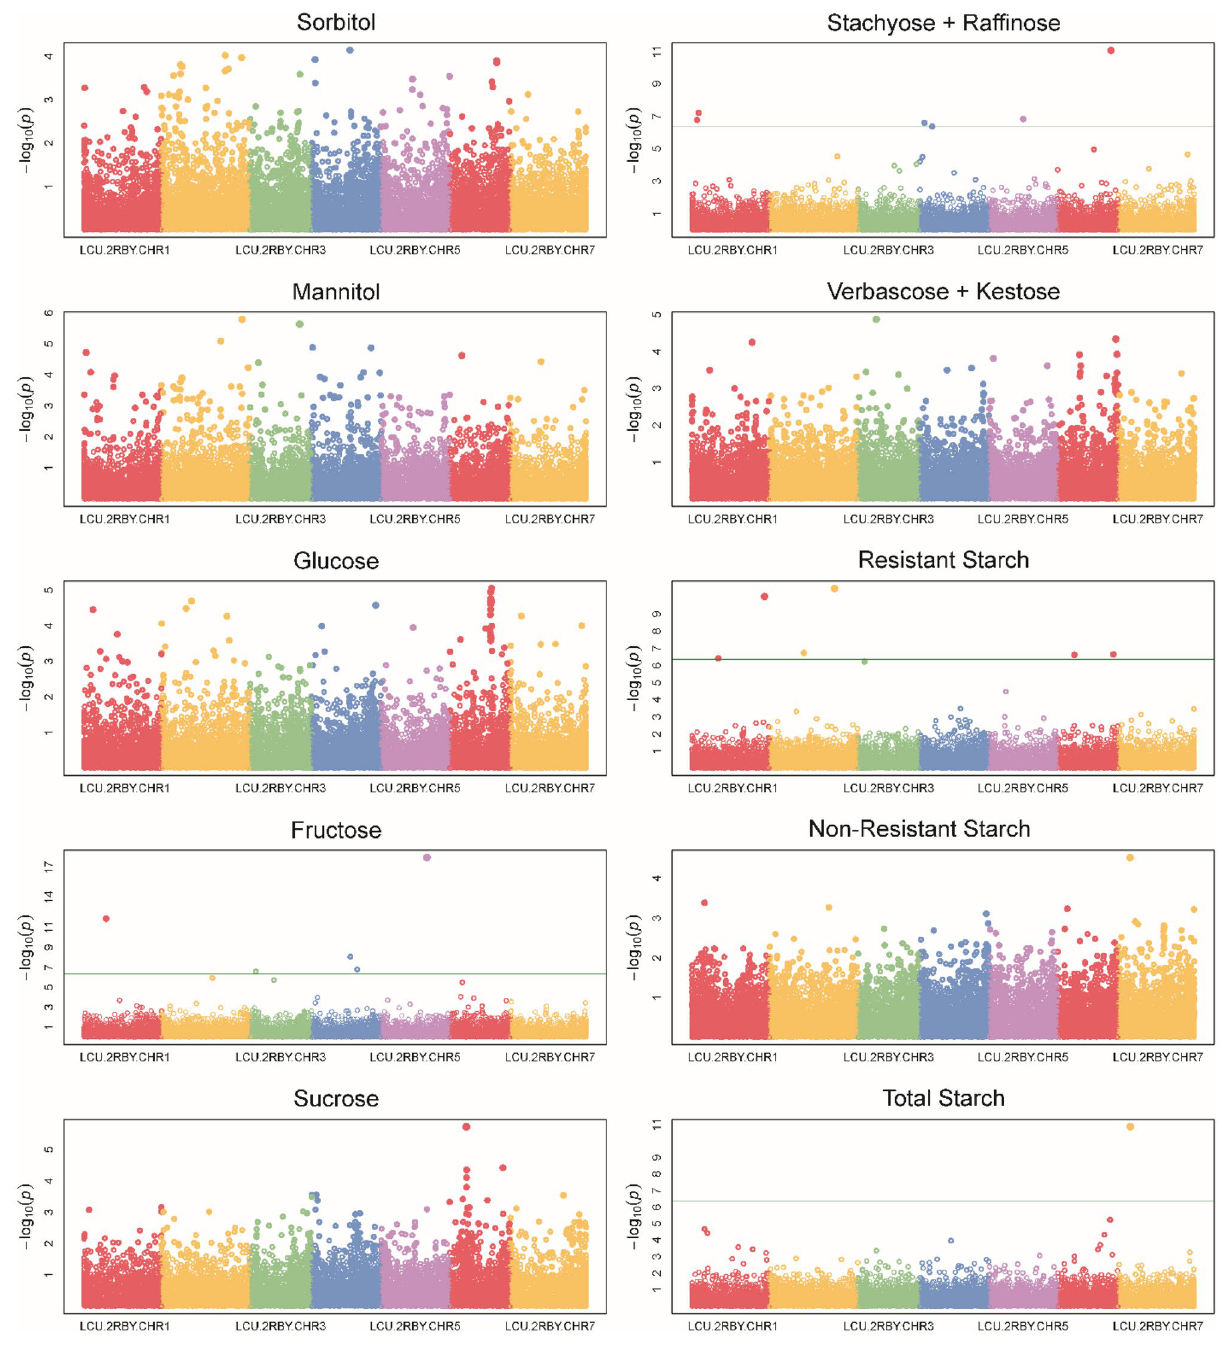
Figure 3. Genome-wide association study Manhattan plots from GAPIT. The green line represents the Bonferonni significance threshold (p <